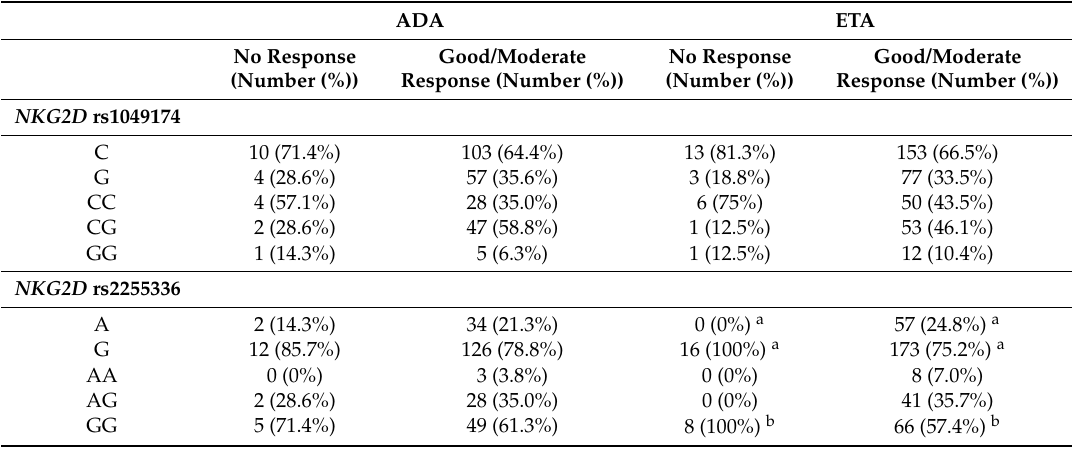
Table 4. Relationships of the NKG2D gene polymorphisms with EULAR responses to adalimumab and etanercept at 12th week of the